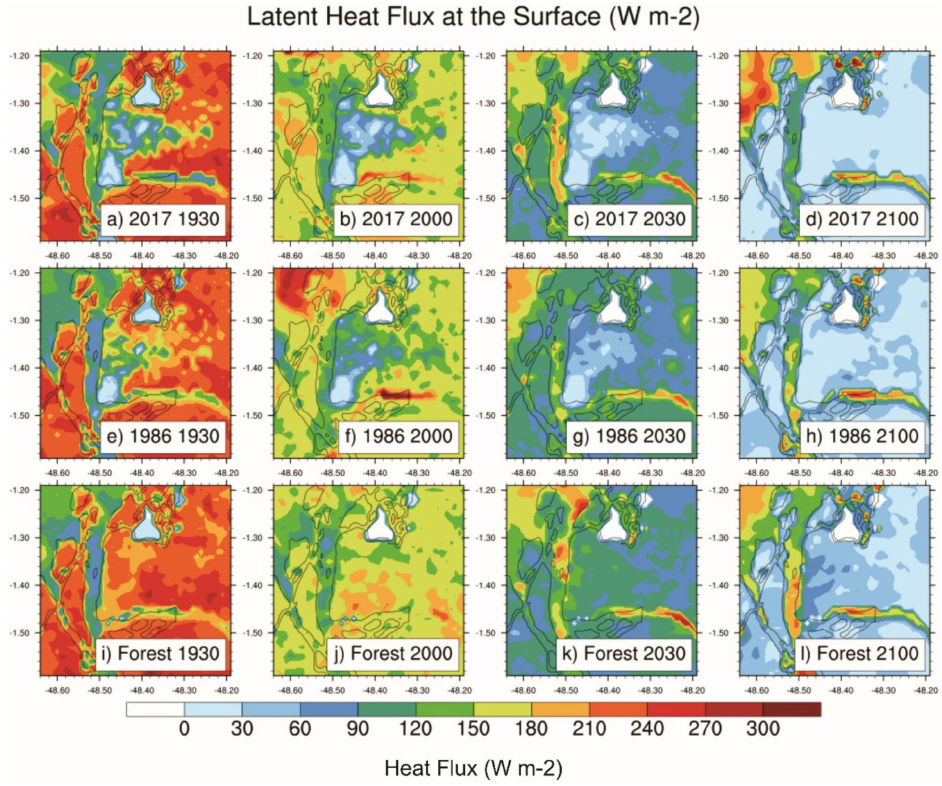
Figure 12. Latent heat fluxes (W m − 2 ) for each of the 2017 ( a – d ), 1986 ( e – h ), and Forest ( i – l ) scenarios at 1930, 2000, 2030, and 2100